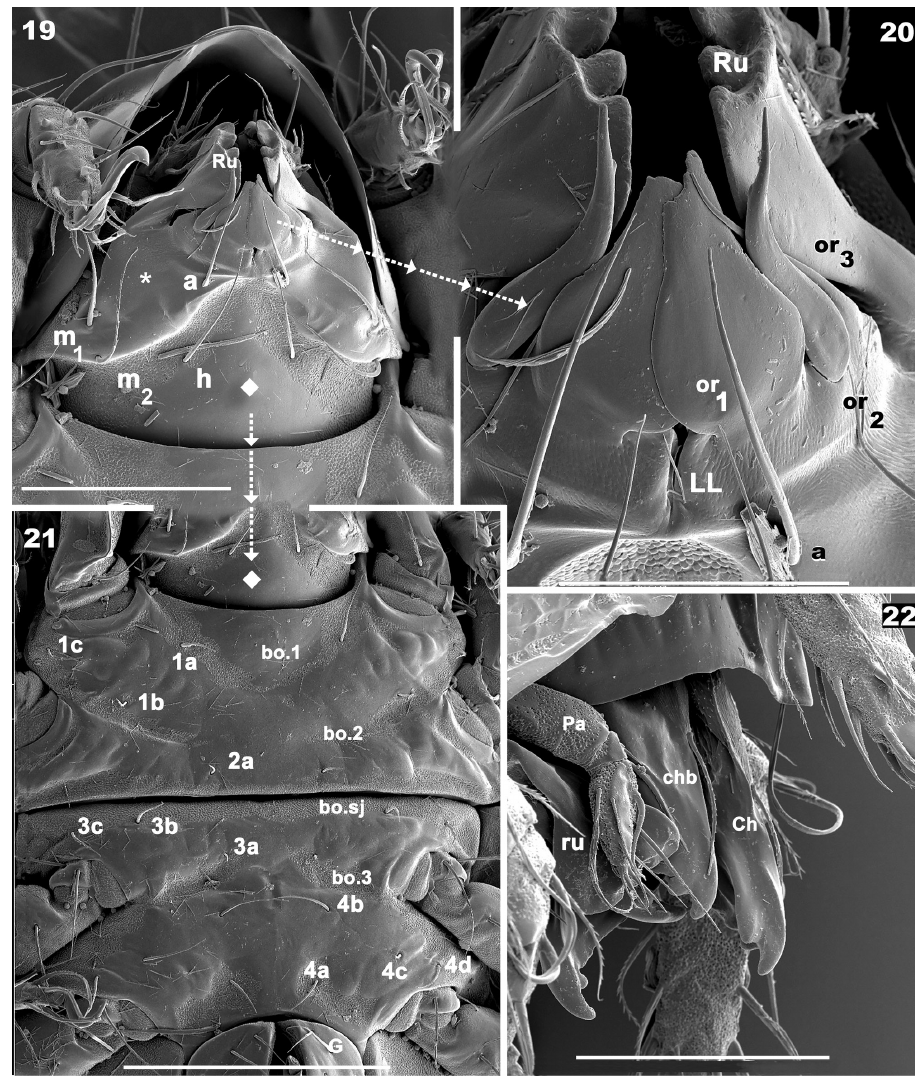
Figures 19–22. Meristacarus perikopesis sp. n. Adult female with cerotegumental layer. SEM micro- graphs. 19 subcapitulum 20 adoral setae 21 epimeral zone 22 rostrum and anterior zone of chelicera and palp. Scale bars: 100 μm ( 19 ); 40 μm ( 20 ); 200 μm ( 21 ); 100 μm ( 22